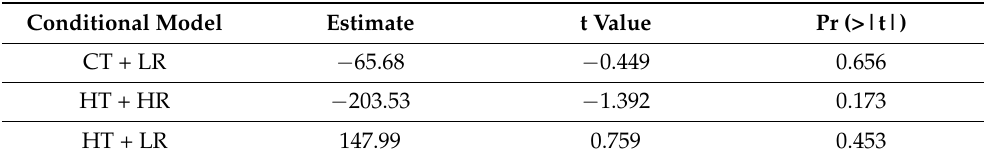
Table 3. Effect of temperature and food availability on two-spotted goby, Pomatochistus flavescens routine metabolic rate (MO2 mg − 1 kg − 1 h − 1 ).